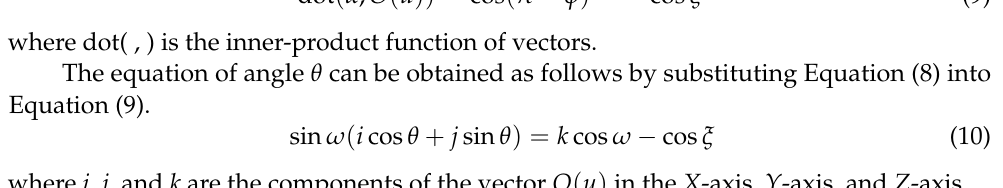
( ) O u and the unit rotation di- ( ) π ξ− , the inner product of the vector